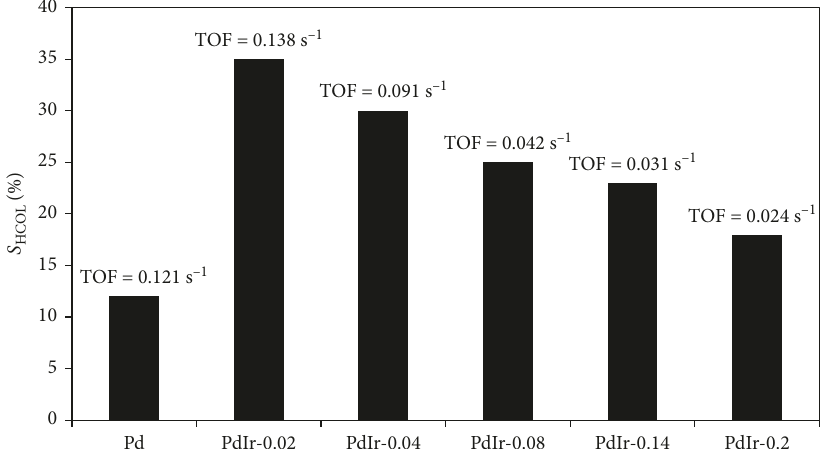
Figure 6: Selectivity to saturated alcohol (HCOL) obtained at 80% conversion of CAL with the TOF values for Pd and PdIr